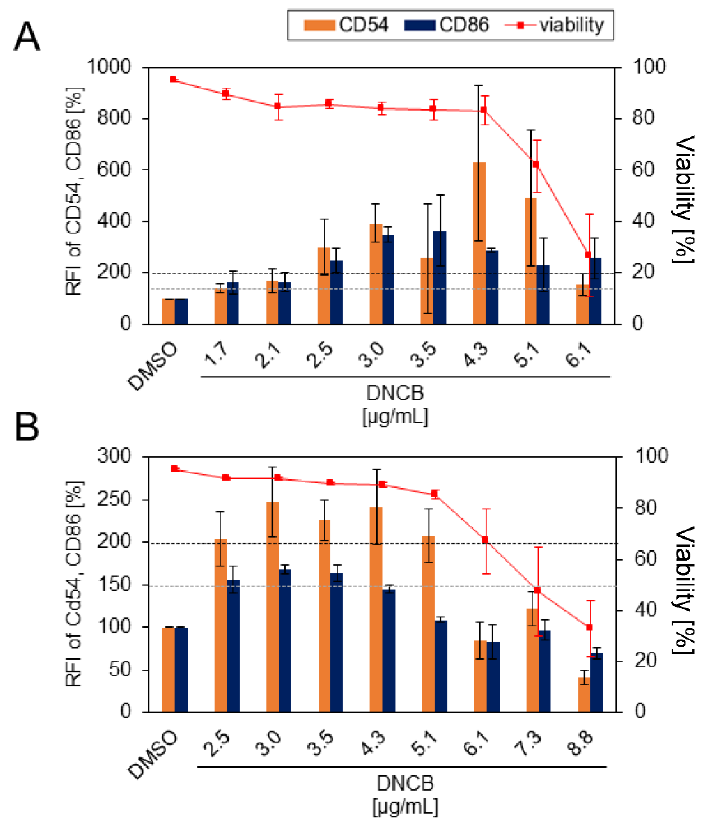
Figure 2. CD54 and CD86 expression induced by DNCB on THP-1 cells in monocultured ( A ) and co-cultured with keratinized NHEK cells ( B ). DNCB solution at eight concentrations prepared based on the CV75 determined for each exposure route was directly exposed to THP-1 cells ( A ), on the other hand, was applied on the surface of keratinized NHEK cells in cell culture insert ( B ). After 24 h of incubation, the expression of CD54 and CD86 and cell viability were analyzed using flow cytometry. Data are shown as relative fluorescence intensity (RFI, % of control). Mean values of RFI ± SD for three individual experiments are shown. The black and gray dashed lines visually indicate the positive criteria for skin sensitization in h-CLAT for CD54 and CD86, respectively (CD54 ≥ 200%, CD86 ≥ 150%).